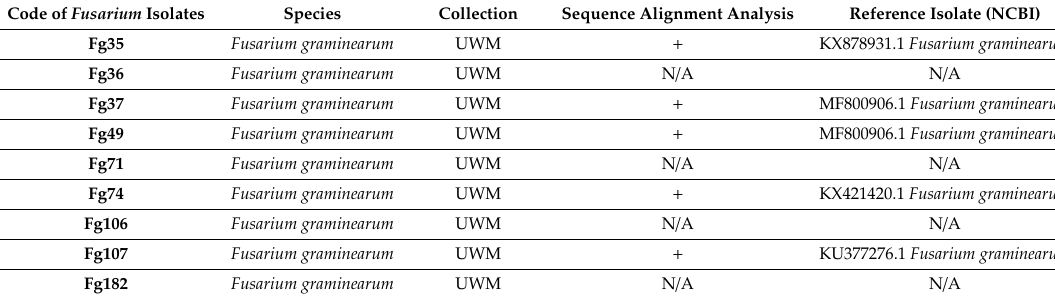
Table 1. List of Fusarium spp.